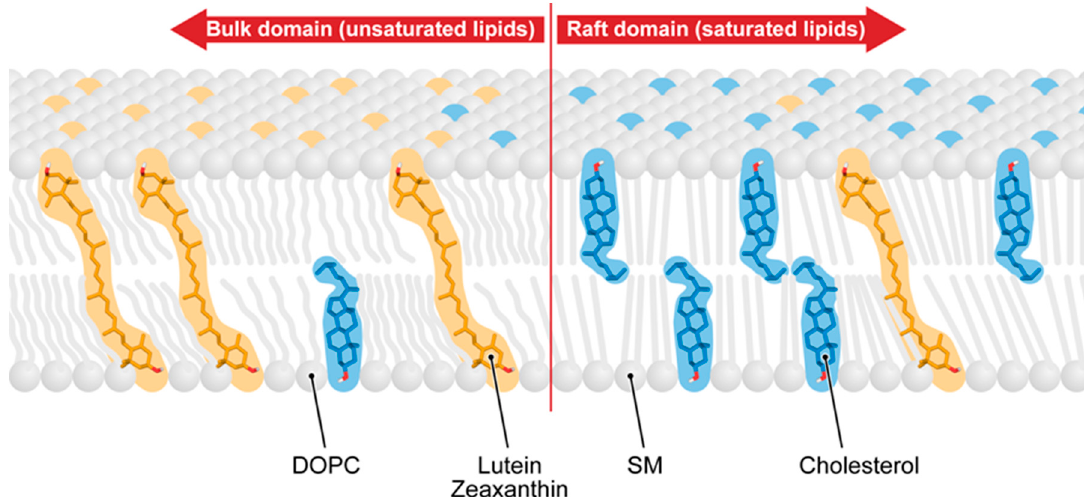
Figure 5. Schematic drawing showing the distribution of macular xanthophylls between the unsaturated bulk domain and the saturated raft domain in lipid-bilayer membranes. (see [90,95] for additional details). DOPC, dioleoylphosphatidyl- choline; SM-sphingomyelin.